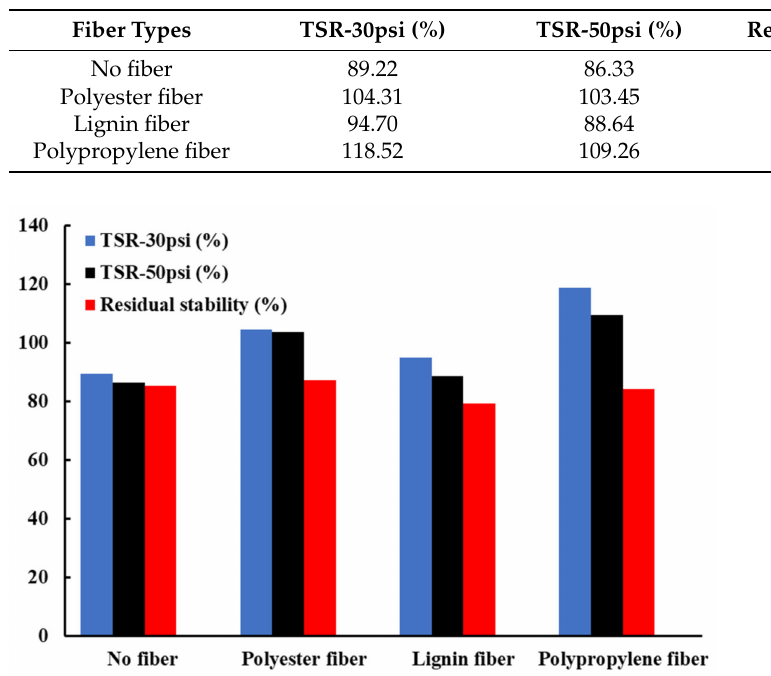
Figure 9. The relationship between the water susceptibility and fiber